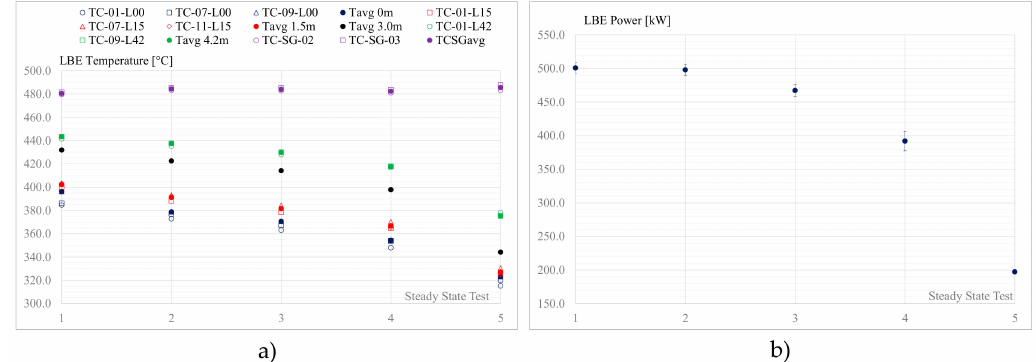
Figure 6. EF-T2: ( a ) LBE temperatures along the SG shell side for all the steady states; ( b ) LBE power and relative standard deviation at steady states.